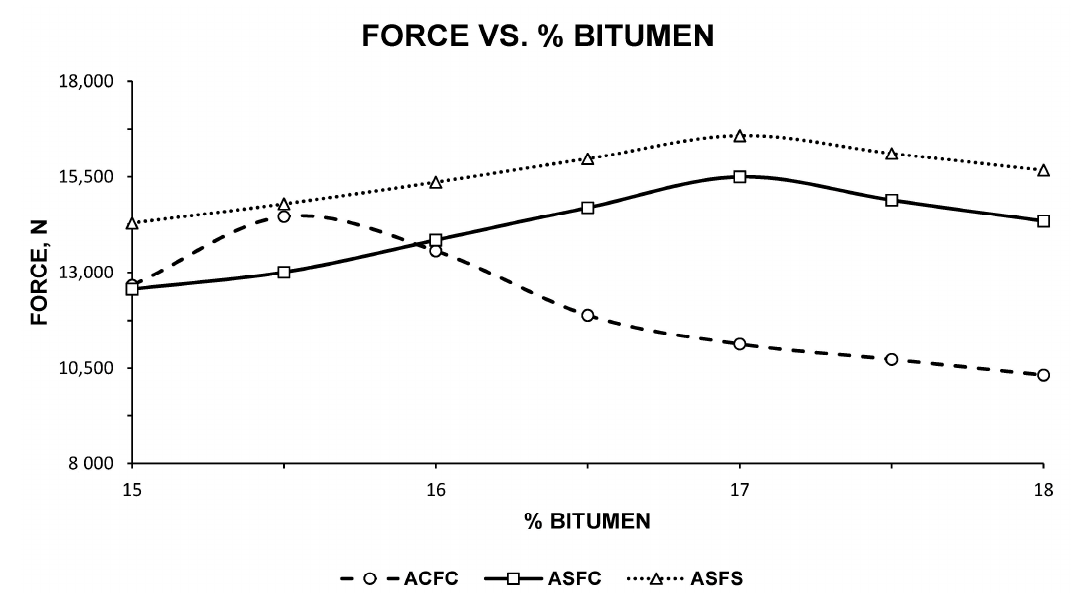
Figure 6. Marshall stability of the families of bituminous mixtures ACFC, ASFC and ASFS with different percentages of bitumen in volume of aggregate.